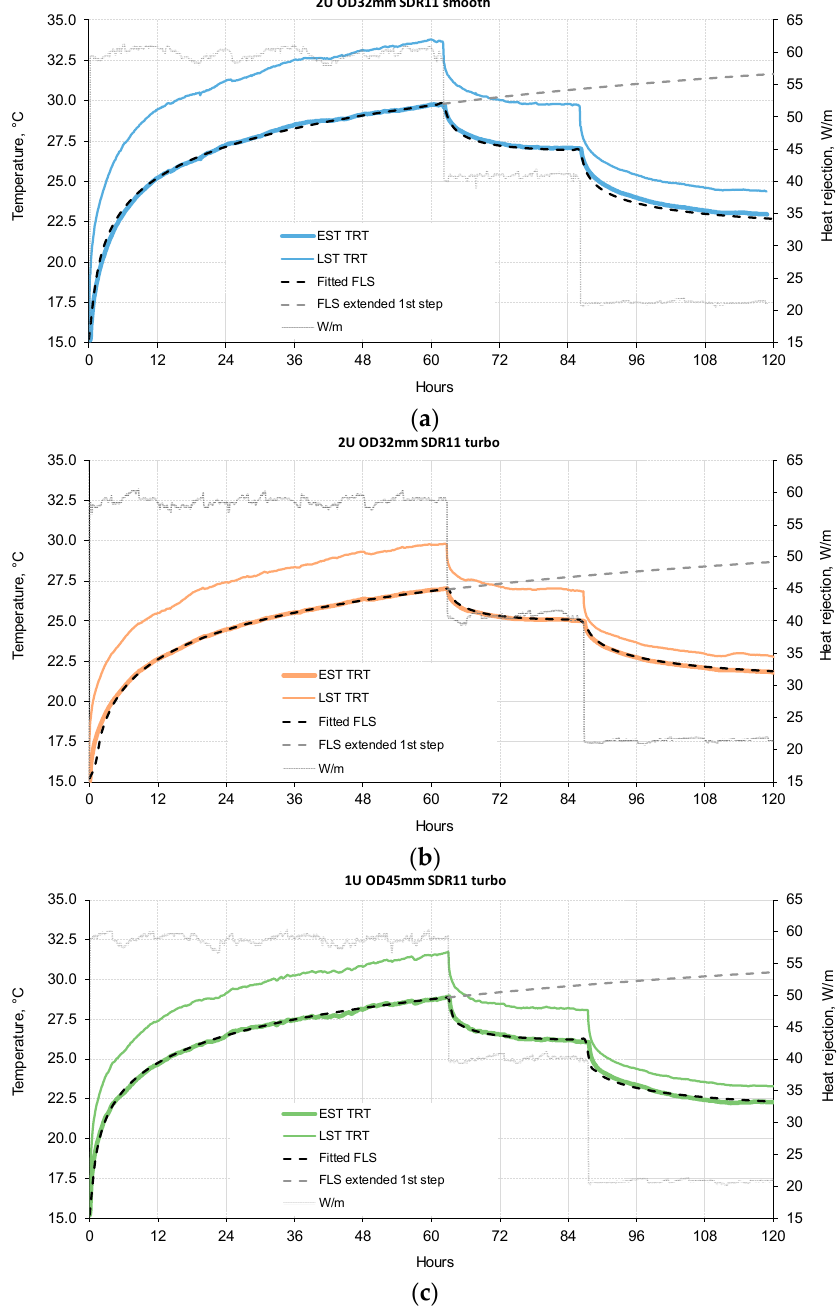
Figure 7. Fitting of measured data with FLS method (use of g-function) for three di ff erent pipe types: ( a ) 2U-pipe, smooth, D32 mm; ( b ) 2U-pipe, turbo, D32 mm; ( c ) 1U-pipe, turbo, D45